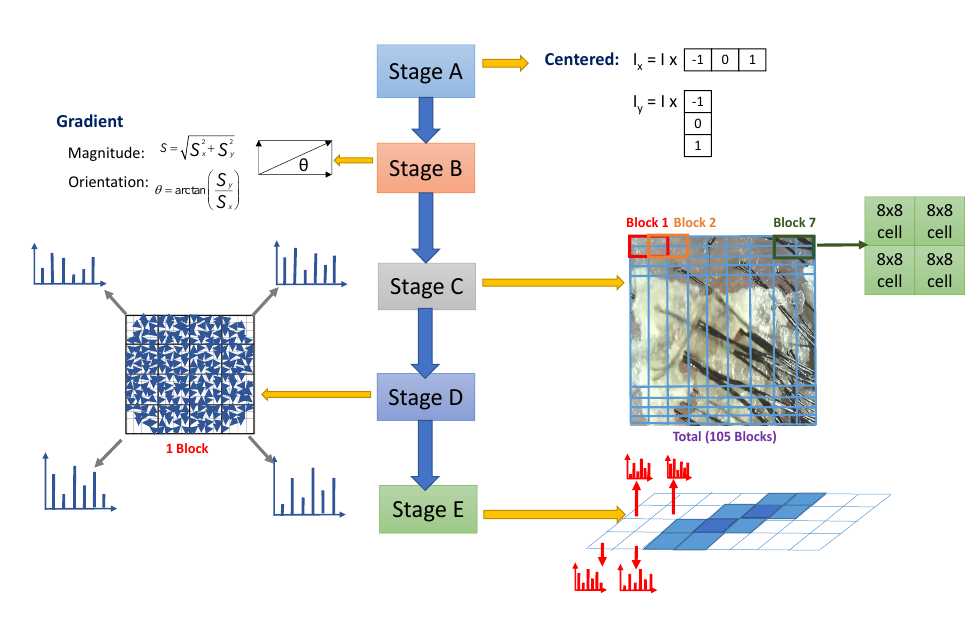
Figure 17. General scheme of HOG.